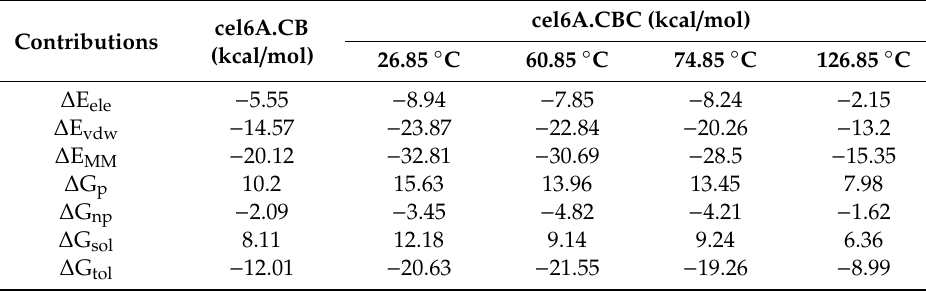
Table 3. Molecular mechanics generalized Born surface area (MMGBSA) binding free energy results for cel6A.CB at standard temperature (26.85 ◦ C) and cel6A.CBC at di ff erent